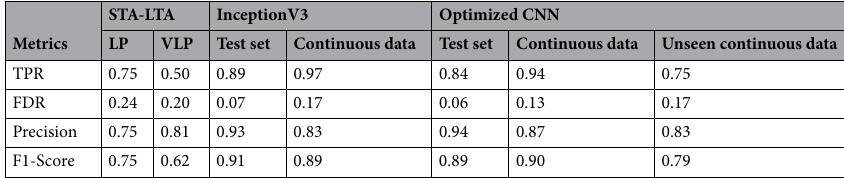
Table 1. Performance of the detection algorithms estimated using the following metrics: true positive rate (TPR = TP/(TP + FN)) also known as recall; false discovery rate (FDR = FP/(TP + FP)); precision (Prec = TP/ (FP + TP)); F1-Score (2*Prec*TPR/(Prec +